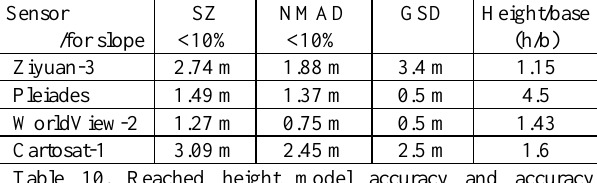
Table 10. Reached height model accuracy and accuracy condition